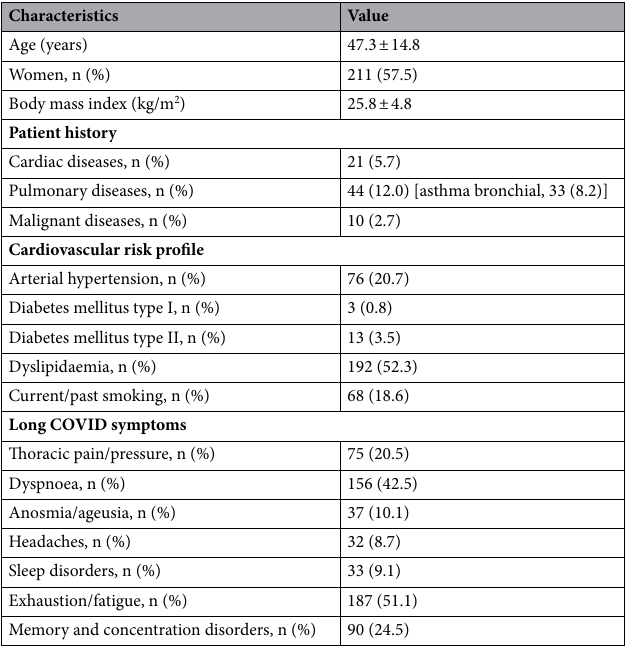
Table 1. Patient characteristics (n = 367). Continuous variables are expressed as means ± standard deviations. Categorical variables are expressed as numbers